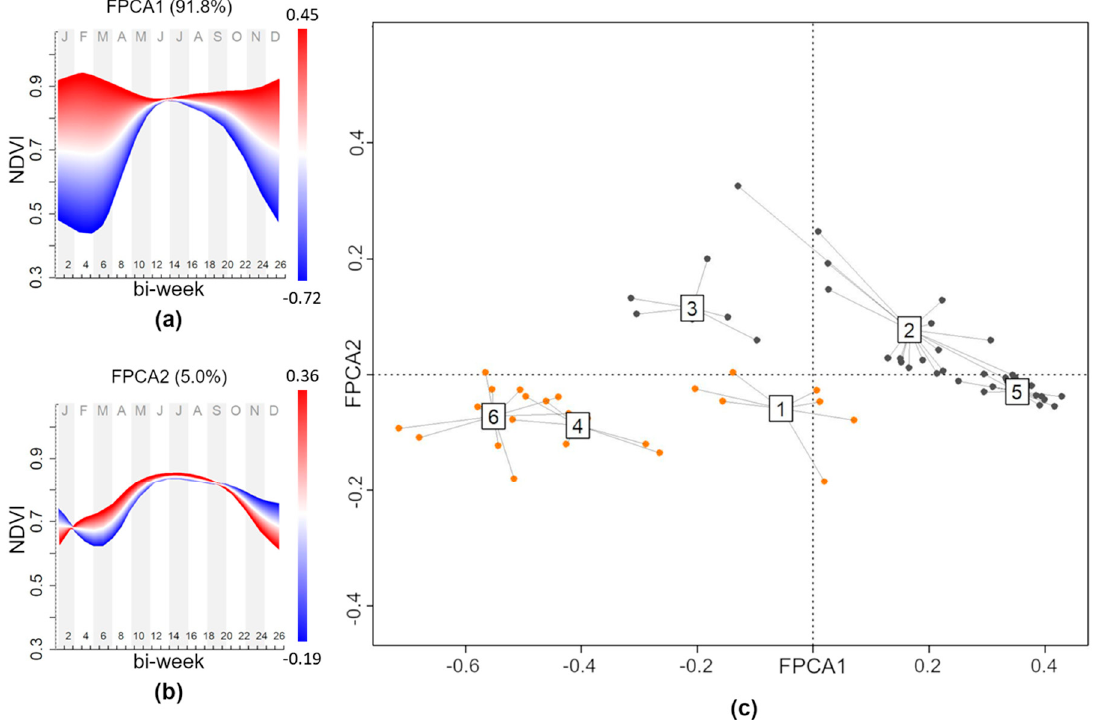
Figure 4. Functional principal component ordination plot of remotely sensed NDVI time series over Mount Valmontagnana and Mount Conero areas (phenological ordination space). ( a ) First FPCA component, FPCA1, describes 91.8% of NDVI variation. Blue and red gradients related to FPCA1 scores. ( b ) Second component (FPCA2) accounts for 5.0% of NDVI variation. Blue and red gradients related to FPCA2 scores. ( c ) Scores related to FPCA1 and FPCA2 components; black hornbeam plant communities linked to Clusters 3, 4, and 6; holm oak plant communities to Clusters 1, 2, and 5. Orange dots linked to Mount Valmontagnana phytosociological relevés; black dots map to Mount Conero ones.